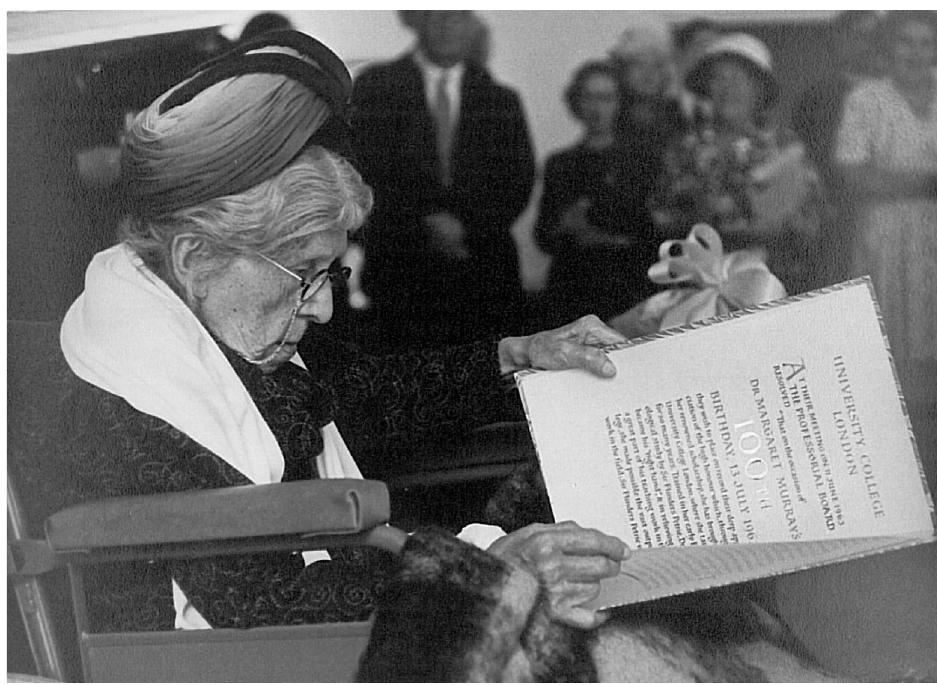
Fig. 1: Margaret Murray on the occasion of her 100th birthday which was marked by the presentation of an address from the Professorial Board (UCL